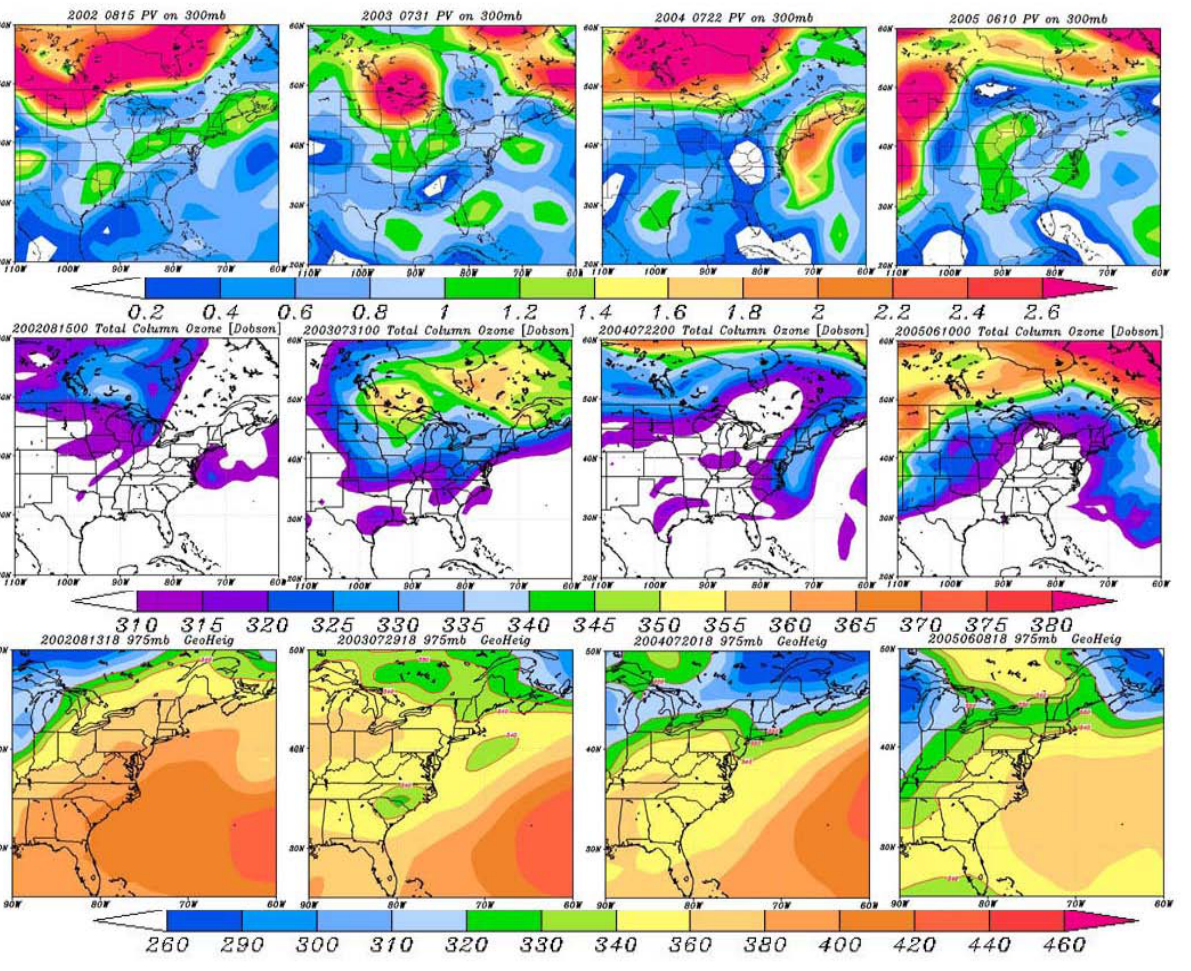
(in Dobson units) 3